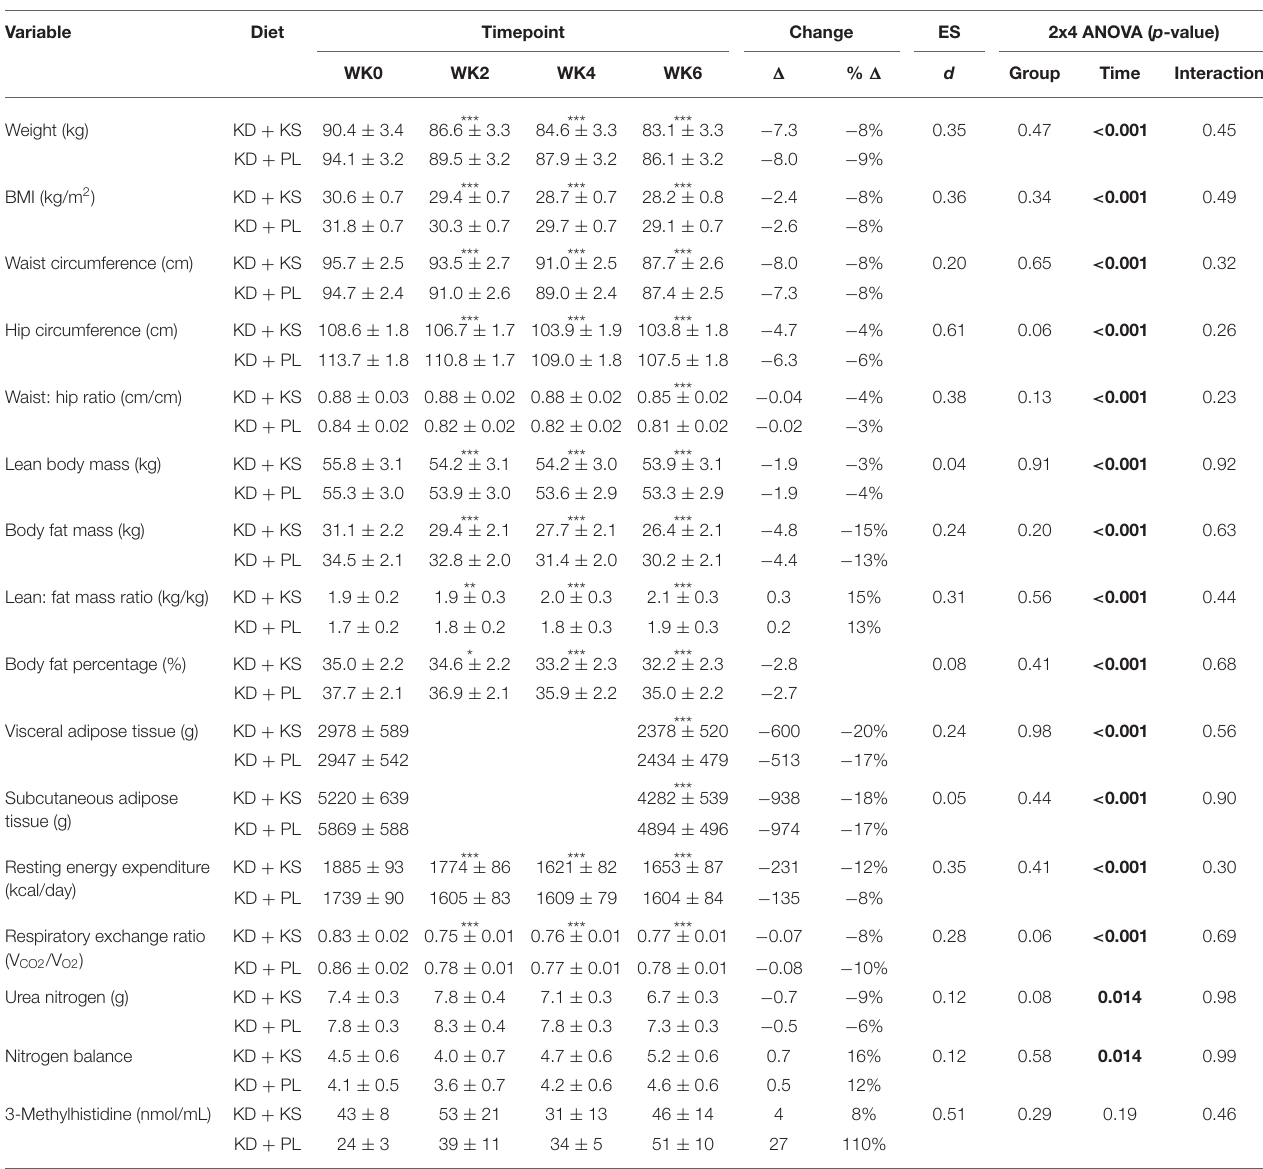
TABLE 3 | Diet effects and interactions.